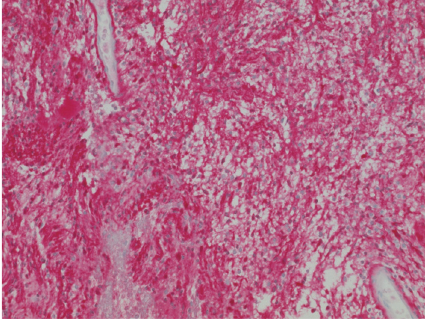
Figure 5: Diffuse immunoreactivity for S-100 protein in neoplastic cells confirms Schwann cell origin of the tumor (200x original